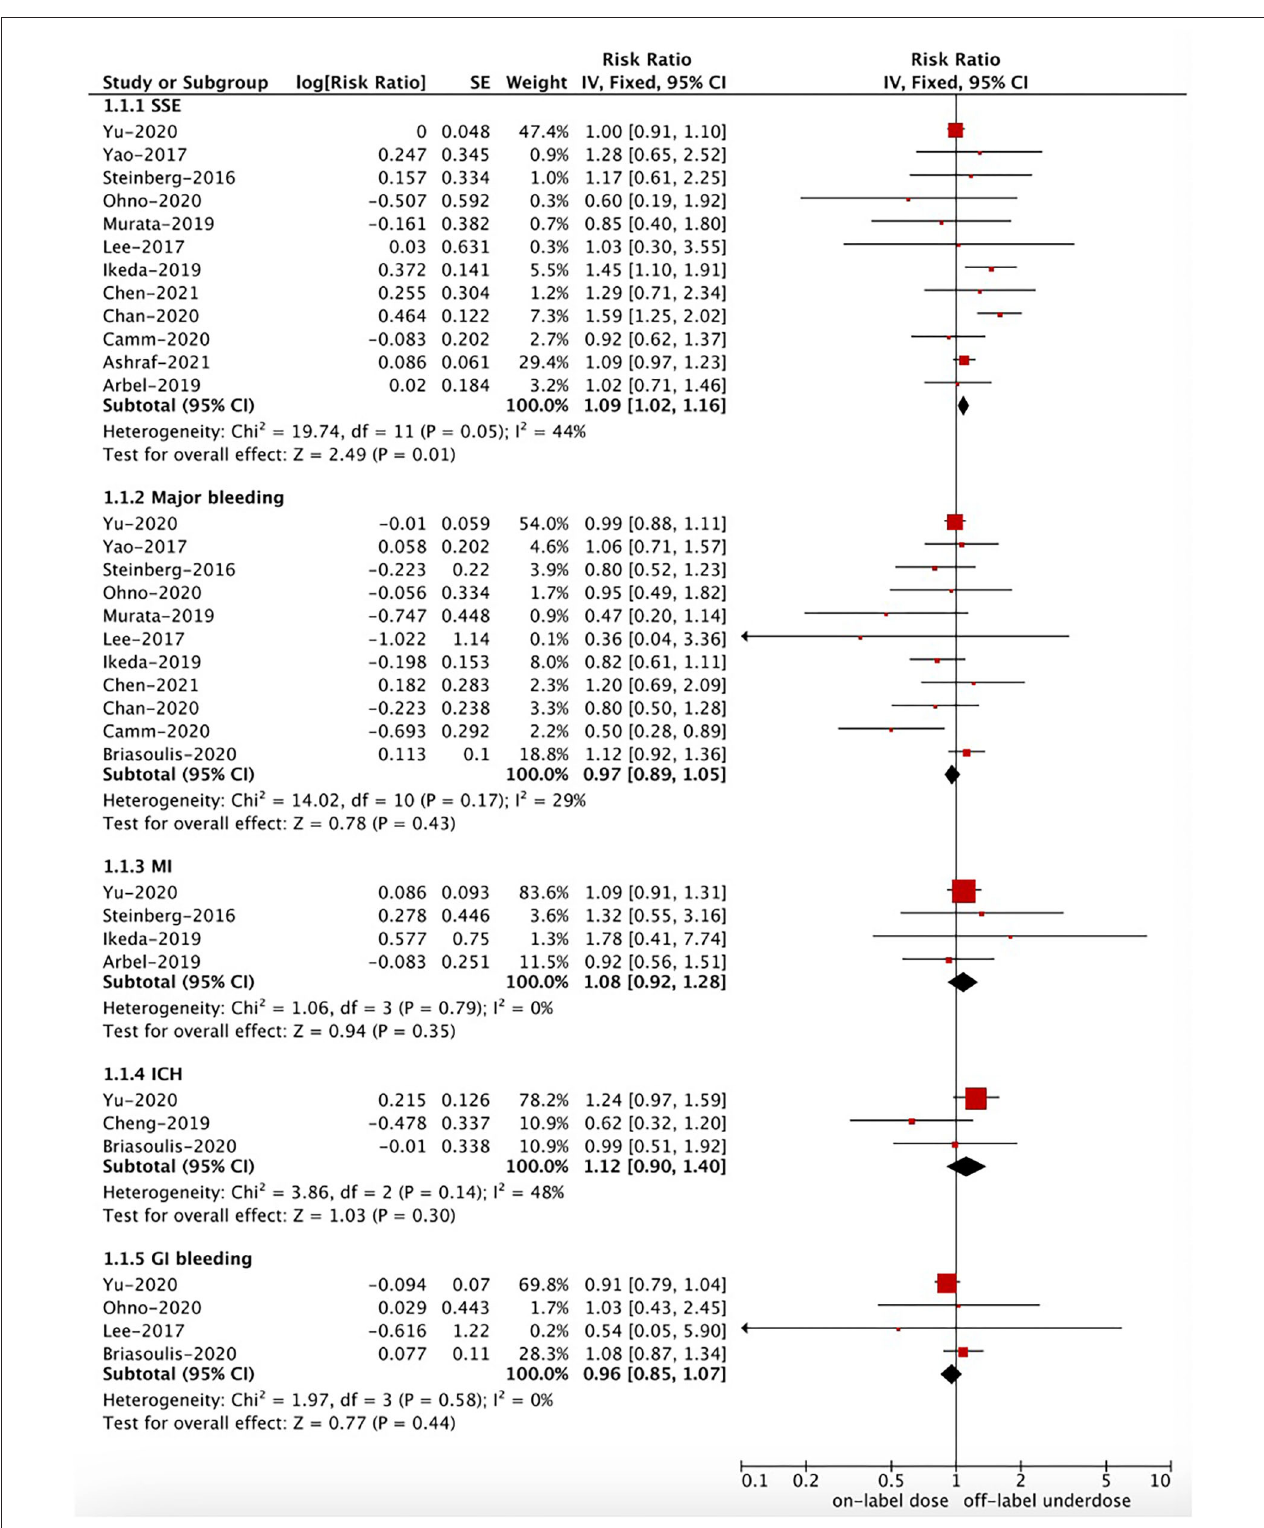
FIGURE 2 | A fixed-effects model for comparing the outcomes between off-label underdose and on-label dose of NOACs in patients with atrial fibrillation. NOACs, non-vitamin K antagonist oral anticoagulants; SSE, stroke or systemic embolism; IS, ischemic stroke; MI, myocardial infarction; ICH, intracranial hemorrhage; GI, gastrointestinal; CI, confidence interval; SE, standard error; IV, inverse of the variance.